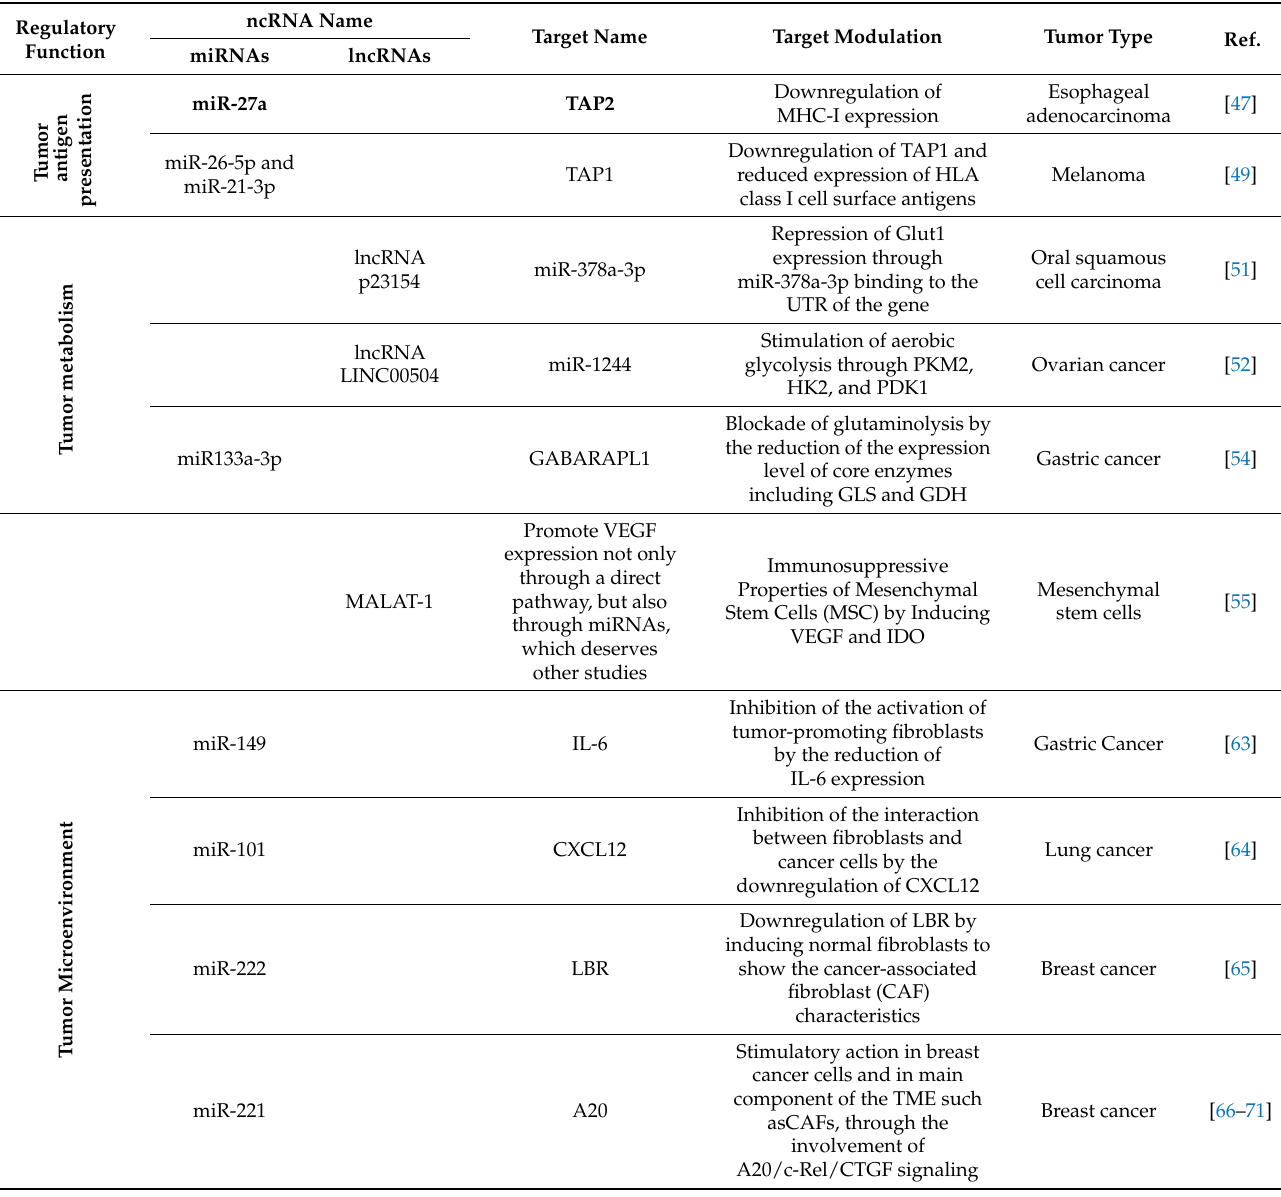
Table 1. miRNAs and lncRNAs involved in cancer immunoediting, tumor cell and microenvironment (TME) modulation, and immunotherapy